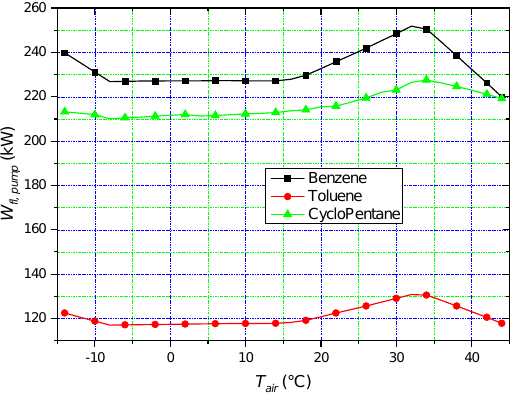
Figure 10. Power absorbed by organic fluid pump varying ambient temperature.